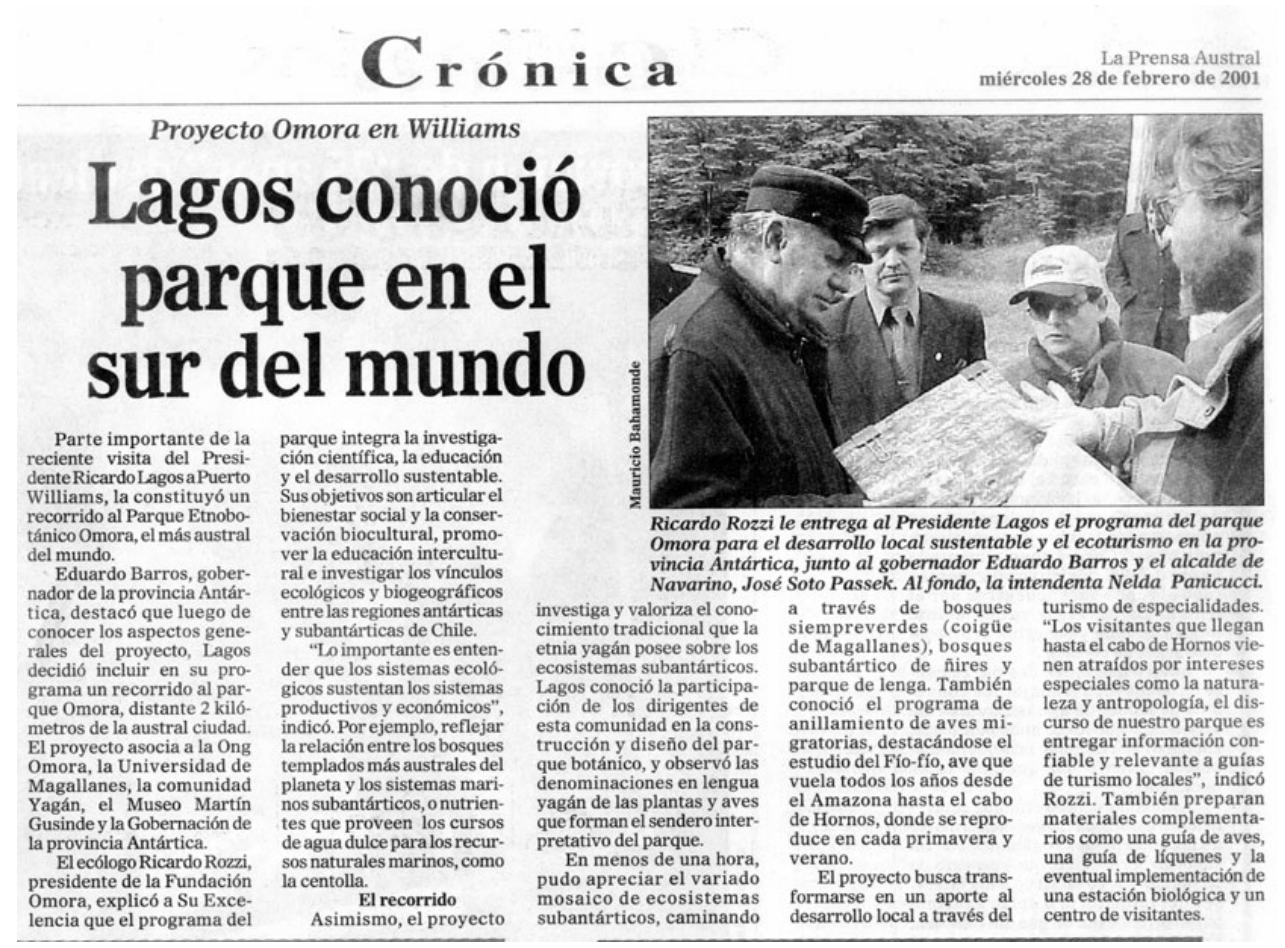
Fig. 5. Communication with the media has allowed Omora to overcome the isolation of Cape Horn and reach a broader audience with novel topics on biocultural conservation. This article reports the visit of the president of Chile, Ricardo Lagos, to the Omora Park ( La Prensa Austral, 28 February